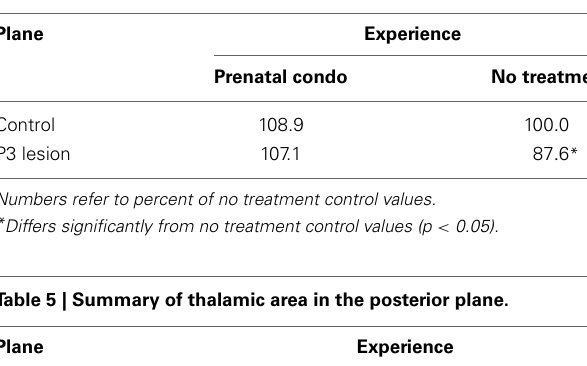
Table 4 | Summary of thalamic area in the anterior plane.